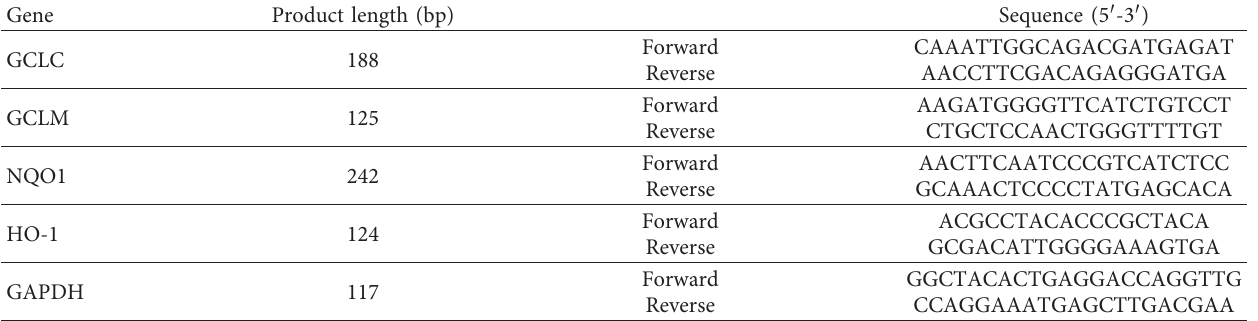
Table 1: Primers sequences used for real-time